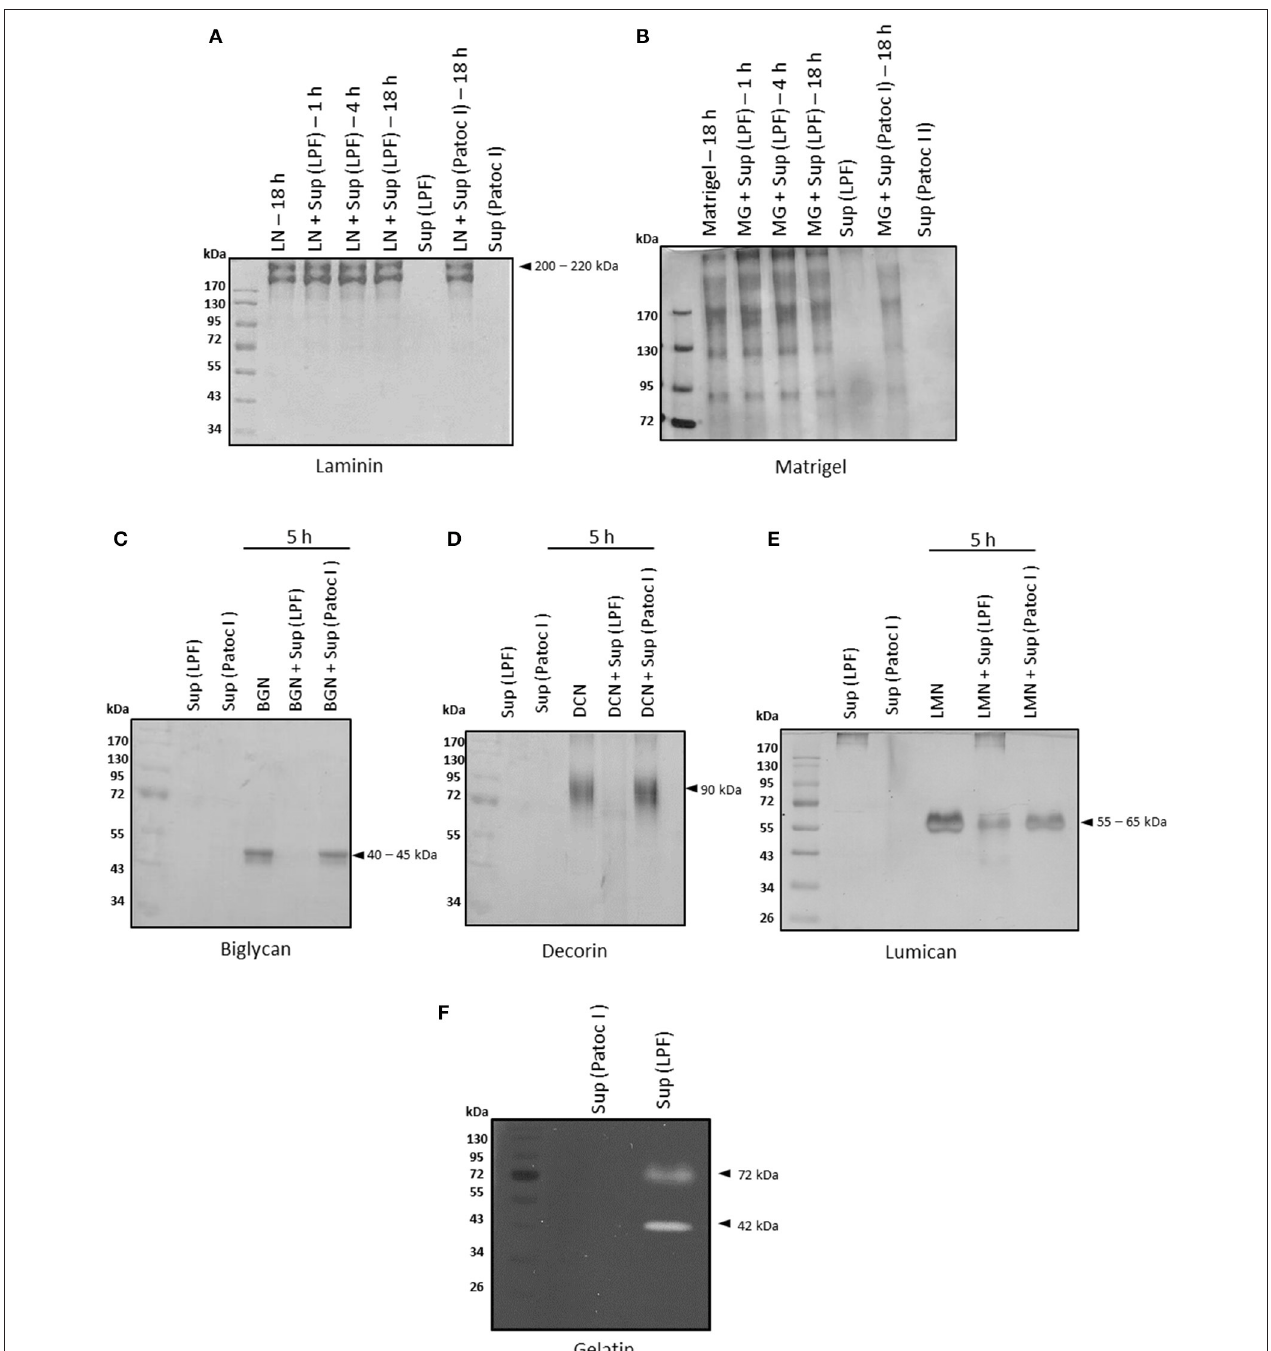
FIGURE 1 | Degradation of ECM proteins by Leptospira interrogans secreted proteins. (A) Laminin (5 µ g), (B) matrigel (5 µ g), (C) biglycan (2 µ g), (D) decorin (2 µ g), and (E) lumican (2 µ g) were incubated with supernatants of pathogenic Leptospira interrogans serovar Kennewicki strain Fromm (LPF) or saprophytic Leptospira biflexa serovar Patoc strain Patoc I (0.5 µ g of total secreted proteins) at 37 ◦ C for the indicated time points. Cleavage products were evaluated by SDS-PAGE under reducing conditions. Gels were silver stained. (F) Proteins present in both supernatants (0.5 µ g of total secreted proteins) were submitted to zymography on a 12% SDS-polyacrylamide gel copolymerized with gelatin and Coomassie Brilliant Blue stained. LN, laminin; MG, matrigel; BGN, biglycan; DCN, decorin; LMN, lumican; Sup (LPF), supernatant of Leptospira interrogans serovar Kennewicki strain Fromm; Sup (Patoc), supernatant of Leptospira biflexa serovar Patoc strain Patoc I.